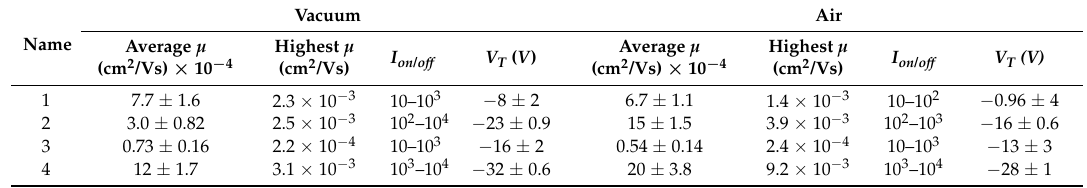
Table 1. Properties of devices tested in vacuum and air for a channel length of 5 µ